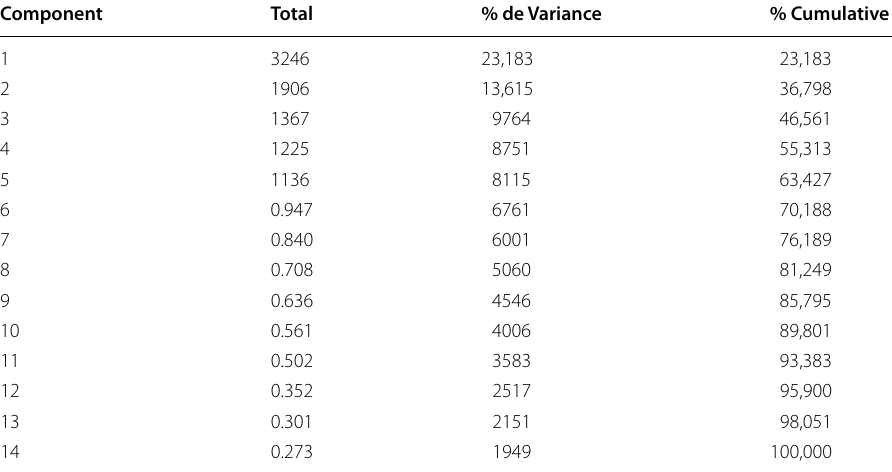
Table 3 Total variance explained for the 14 main sample components